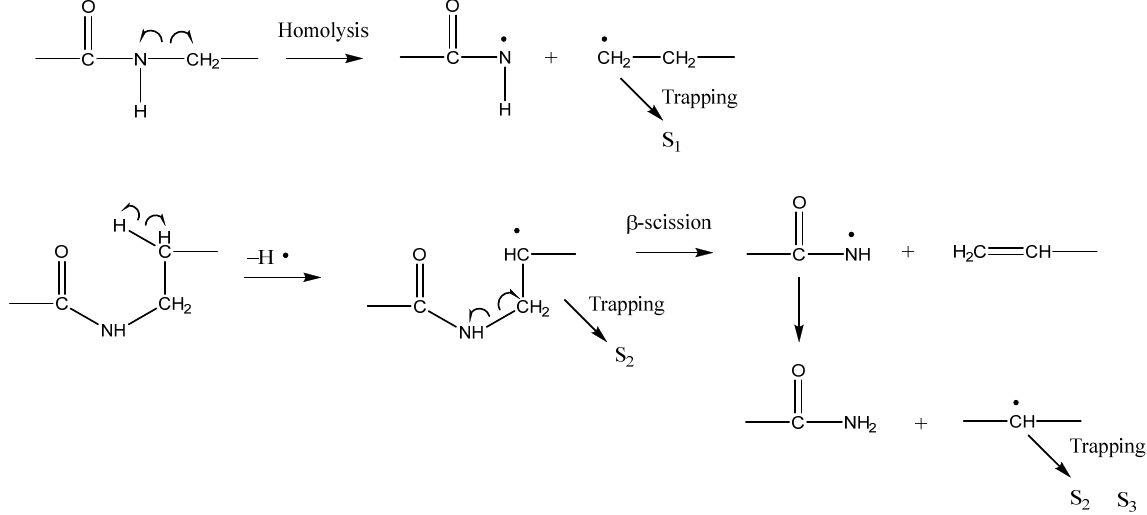
Figure 6. Radical amounts of spin adduct produced during stepwise heating of the PA66